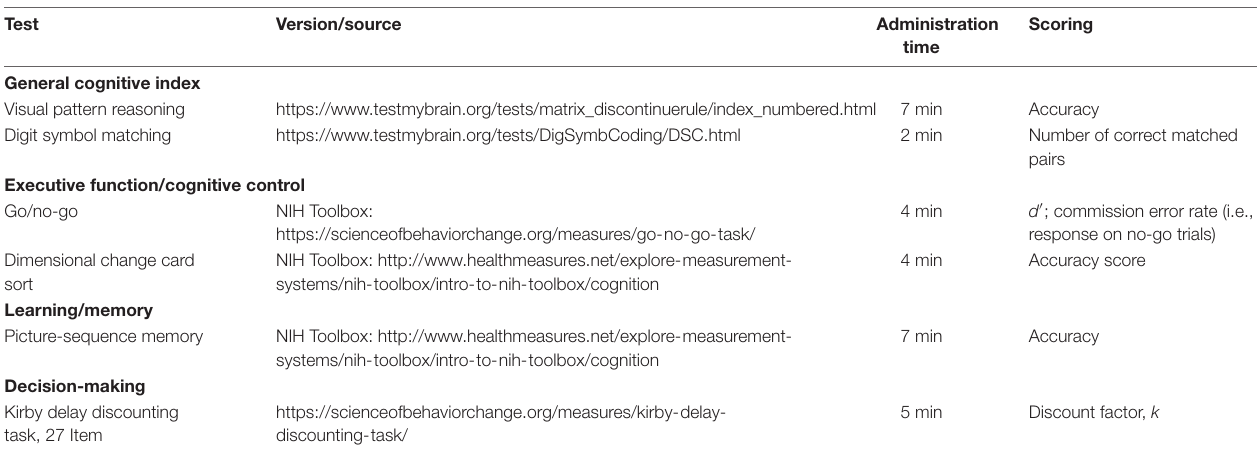
TABLE 3 | Standard